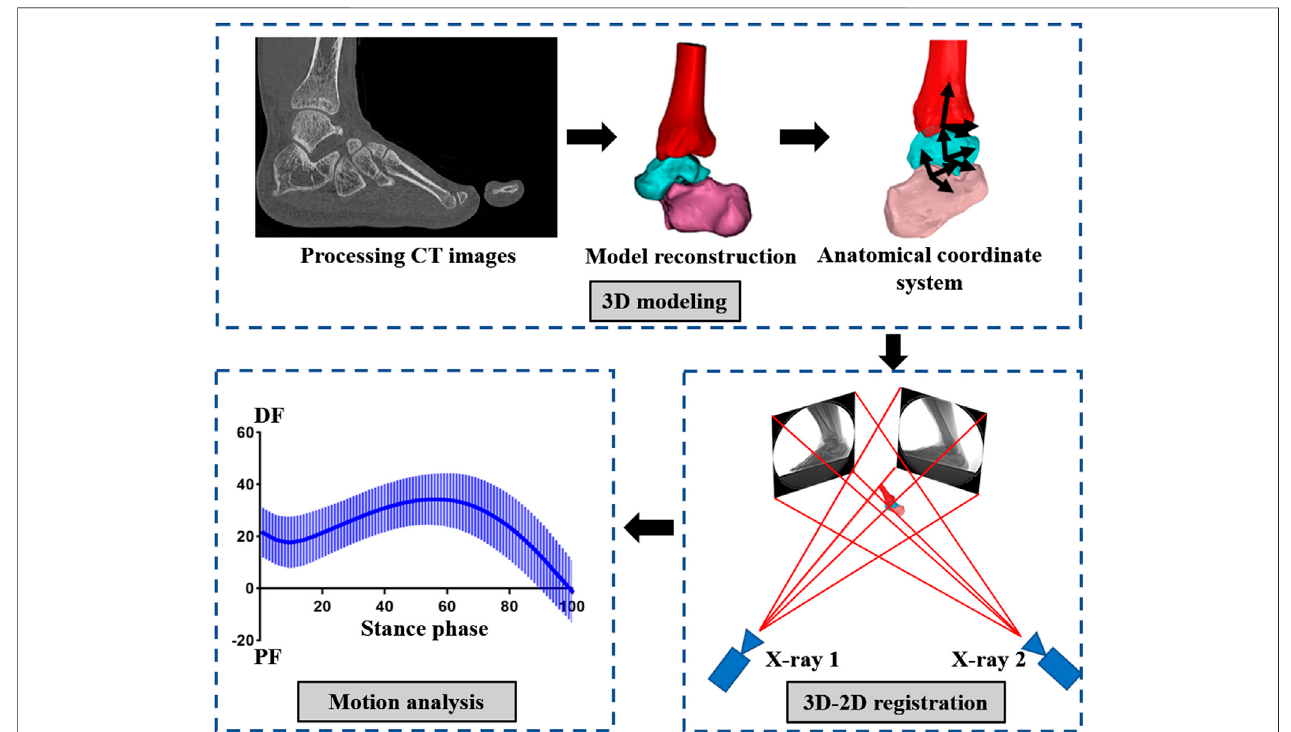
FIGURE 3 | Flowchart of data collection and analysis using